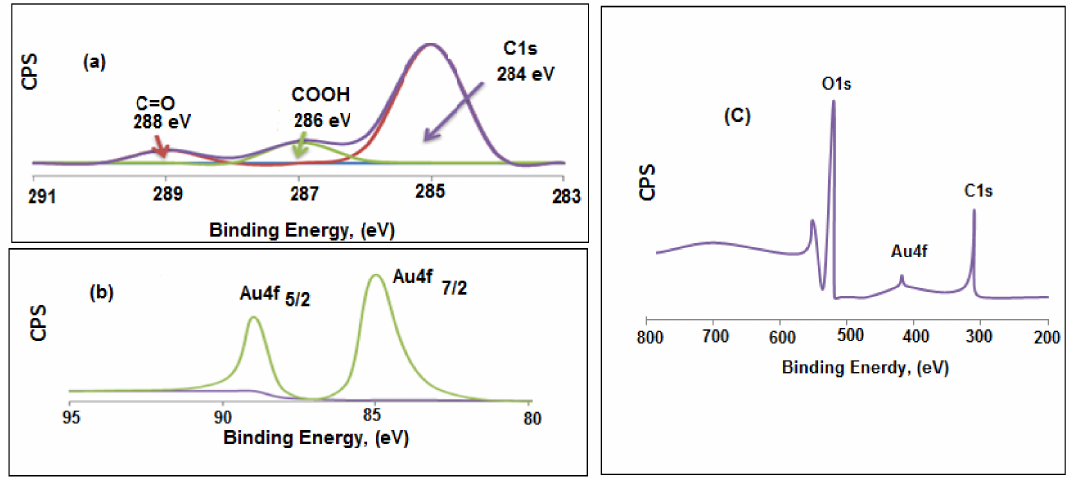
Figure 4. X-ray photoelectron spectroscopy (XPS) spectra of ( a ) CQDs ( b ) Au ( c ) CQD/Au nanocomposite.